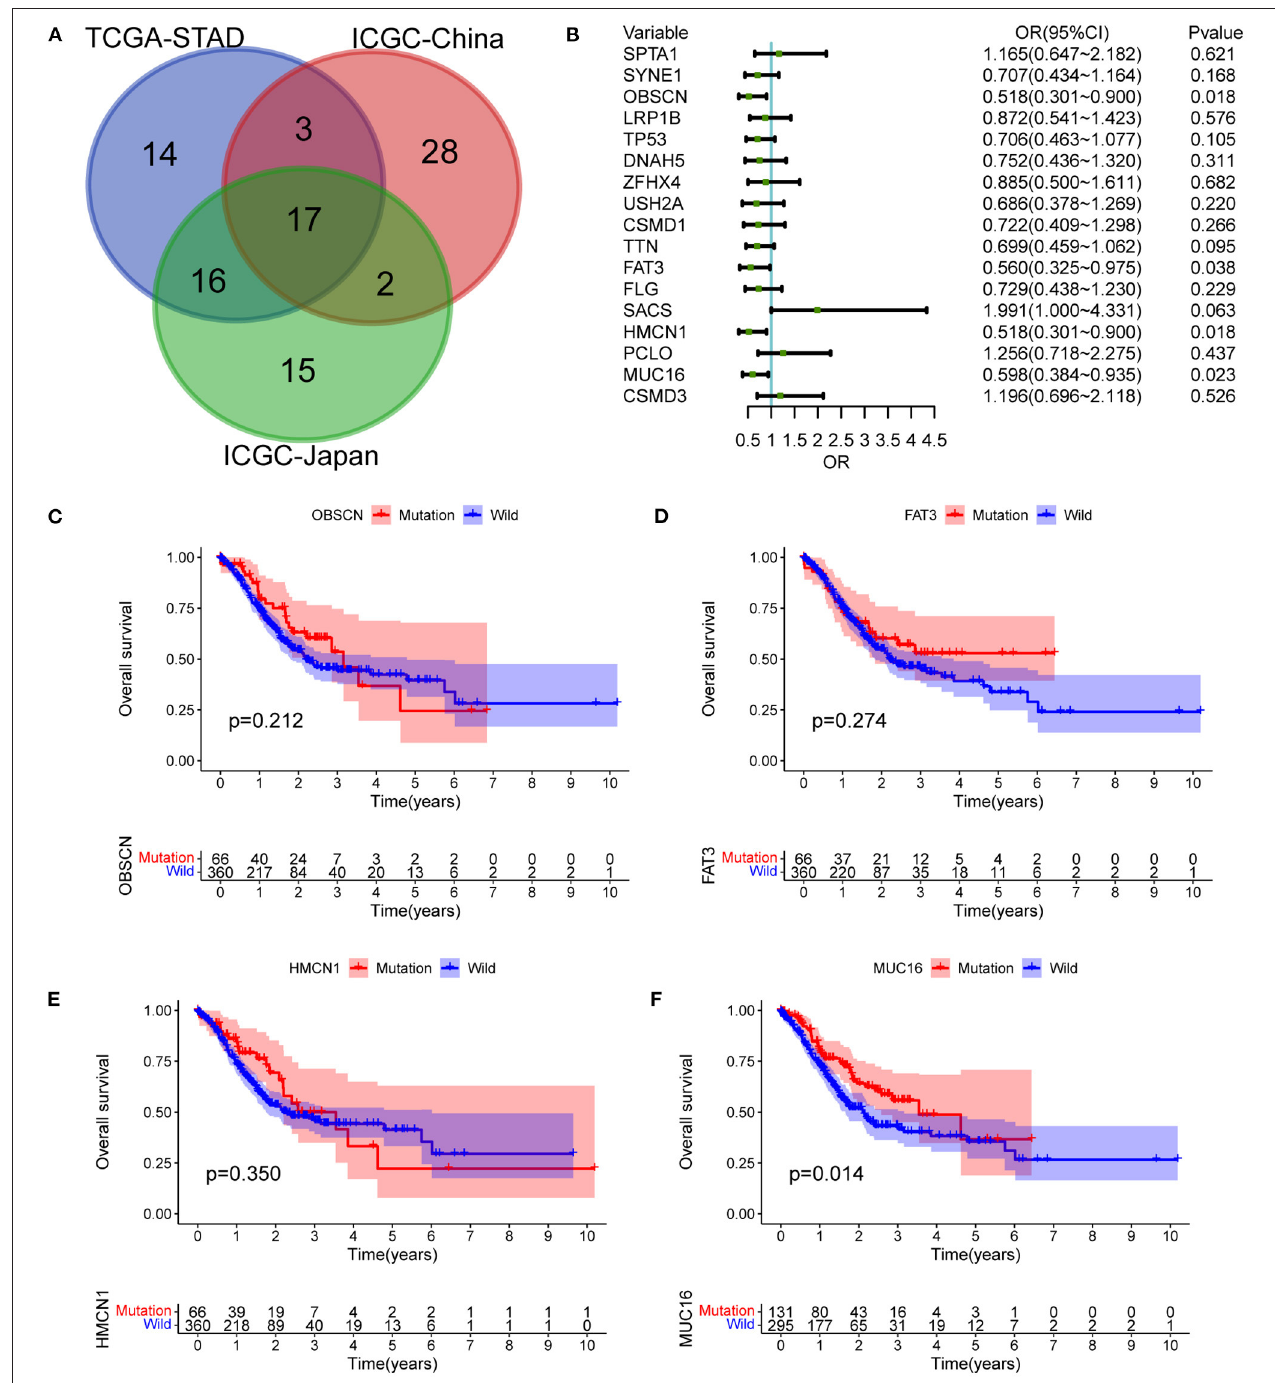
FIGURE 3 | Mutant genes associated with LNMs and outcomes. (A) Venn diagram demonstrating intersections of most common mutated genes between three cohorts. (B) Univariate logistic regression analysis showing influencing factors for LNMs in TCGA-STAD cohort. (C) OS stratified by OBSCN mutation status. (D) OS stratified by FAT3 mutation status. (E) OS stratified by HMCN1 mutation status. (F) OS stratified by MUC16 mutation status. OBSCN, Obscurin, Cytoskeletal Calmodulin And Titin-Interacting RhoGEF; HMCN1, Hemicentin 1; FAT3, FAT Atypical Cadherin 3; MUC16, Mucin 16, Cell Surface Associated.